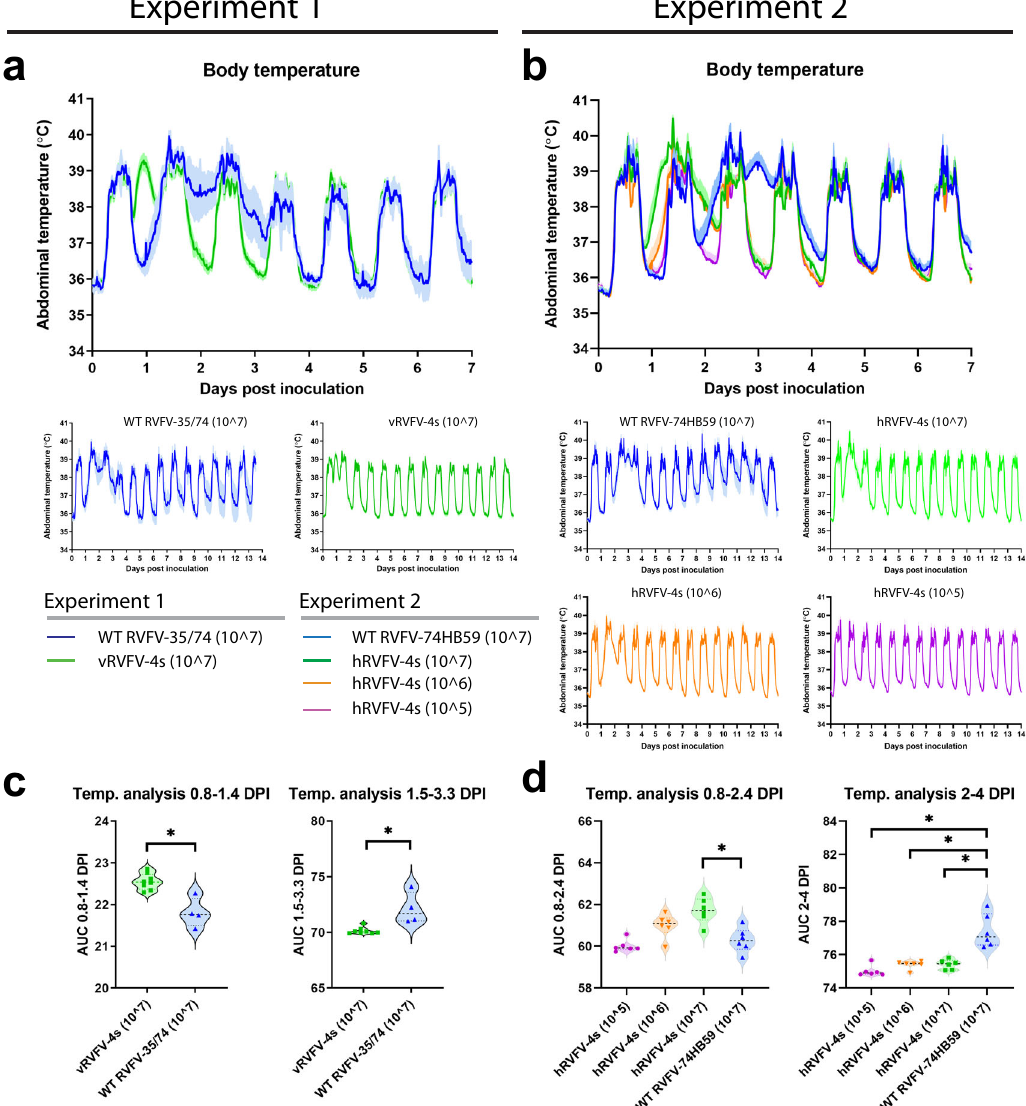
Fig. 3 Dose-dependent early-phase temperature increase following inoculation of marmosets with RVFV-4s. Body temperatures in experiment 1 ( a ) and experiment 2 ( b ) were recorded every 15 min using an AniPill telemetric device in the abdominal cavity. Averages and SEM are presented for each group. Area under the curve (AUC) measurements were performed at the indicated days post inoculation (DPI) to assess statistically signi fi cant differences between groups of experiment 1 ( c ) and, groups of experiment 2 ( d ). Data are presented as violin plots with medians (dashed line) and were analyzed by ( c ) unpaired t -test or ( d ) one-way ANOVA using Dunnett ’ s multiple comparisons test and comparing the individual vaccine groups to the corresponding wild-type virus groups (GraphPad Prism 9.0). Statistical signi fi cance ( p value ≤ 0.05) is indicated with an asterisk